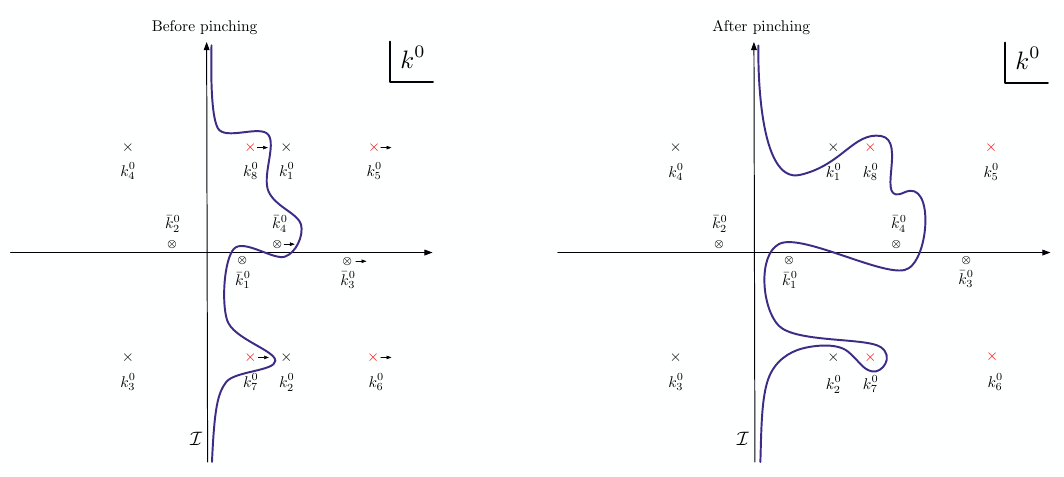
Figure 1 . Integration path for the one-loop bubble diagram in the complex energy plane k 0 before and after the pinching. The poles k 0 and k 0 move from the left to the right (left panel) till they 8 7 pinch the integration path and they swap with the poles k 0 and k 0 , respectively (right panel). As 1 2 proven in the main text, the pinching singularity is integrable and does not give any contribution to the imaginary part of the amplitude, but it contributes to the real part, as evident in figures 2 and 3. Notice that also ¯ k 0 and ¯ k 0 move towards the 3 4